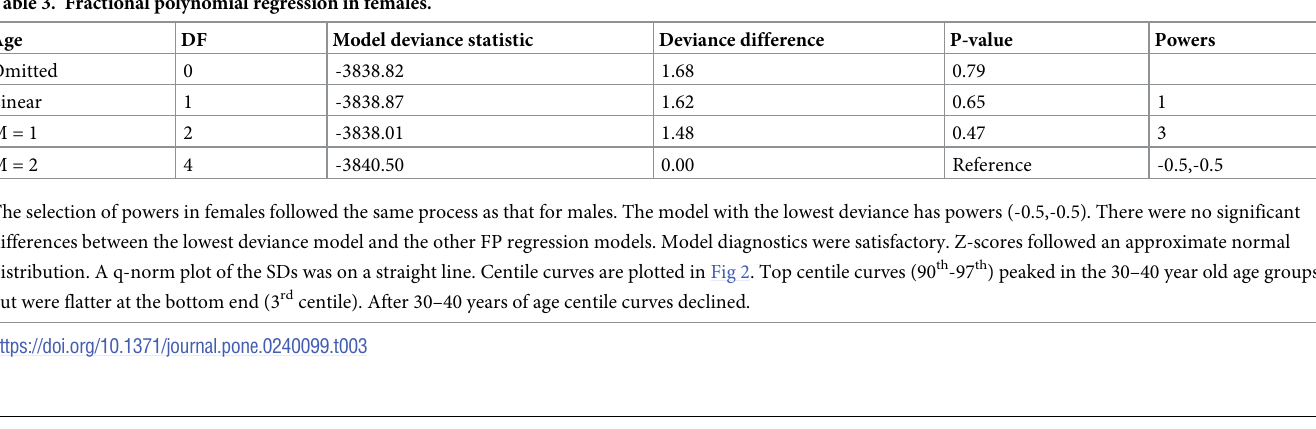
There were no significant differences between any of the FP regressions for either males (Table 2) or females (Table 3), indicated by the ‘difference from the lowest deviance’ statistic. The ‘best fit’ model statistically is the one with the lowest deviance. We selected mean powers (-0.5, 0 males) and (-0.5,-0.5) females; SD powers (1) for both. Model diagnostics were ade- quate for both sexes. Z-scores followed an approximate normal distribution. Q-norm plots of SDs were on a straight line. Tables 2 and 3 showed a number of plausible models. We com- pared powers (-0.5, 0 males) and (-0.5, -0.5 females) and their linear models (3 rd , 50 th , 97 th cen- tiles for illustration)). In males, a straight line closely matched those developed by FP. In females, the largest discrepancy within centiles was seen in the highest centile. This was observed in both younger and older women. In the lower centiles, less marked but similar pat- terns were found. Model diagnostics were adequate for both sexes. Figs 1 and 2 illustrate centile curves for males and females, respectively. In males, curves showed a steady decline until 65–70 years, no matter what the centile. The pattern was differ- ent in females where women aged 30–40 years peaked in the upper centiles especially, and fell away quickly.